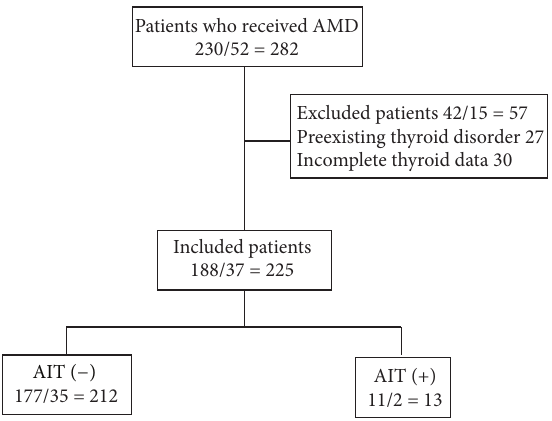
Figure 1: Retrospective cohort study design. Subgroups show the group name and registered number of male/female = total patients